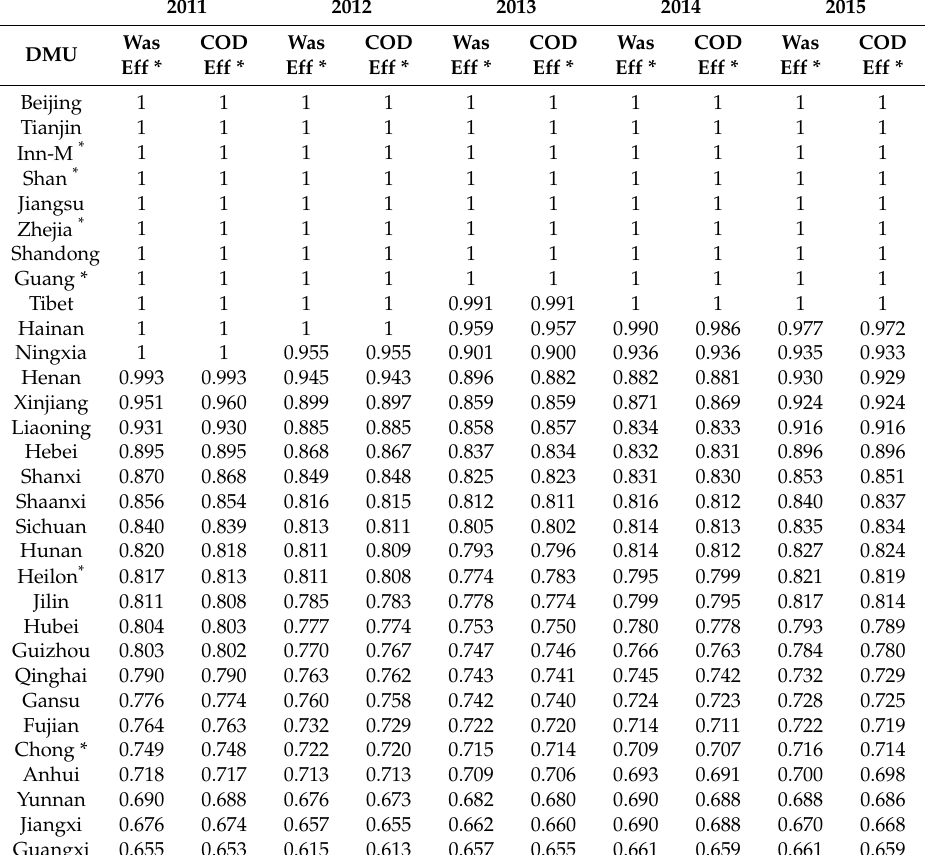
Table 4. Efficiency results of outputs from 2011 to